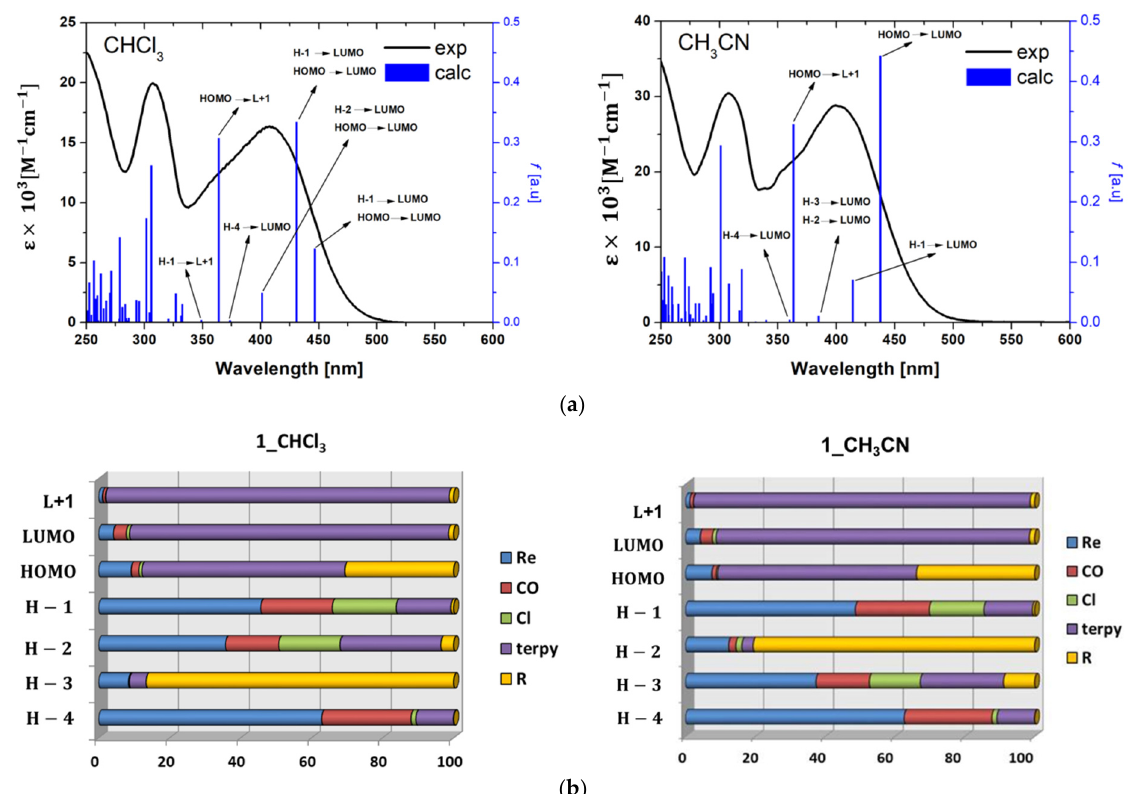
Figure 3. ( a ) Experimental (black line) absorption spectra of 1 alongside blue vertical lines presenting singlet–singlet transitions with corresponding oscillator strengths, computed at TD-DFT/PCM/PBE1PBE/def2-TZVPD/def2-TZVP level with the use of the PCM model at polarities corresponding to CH 3 CN and CHCl 3 ; ( b ) percentage composition of molecular orbitals for compound 1 computed at the DFT/PBE1PBE/def2-TZVPD/def2–TZVP level with the use of the PCM model at polarities corresponding to CH 3 CN and CHCl 3 . For complex 2 , see Figures S25–S27 in ESI.